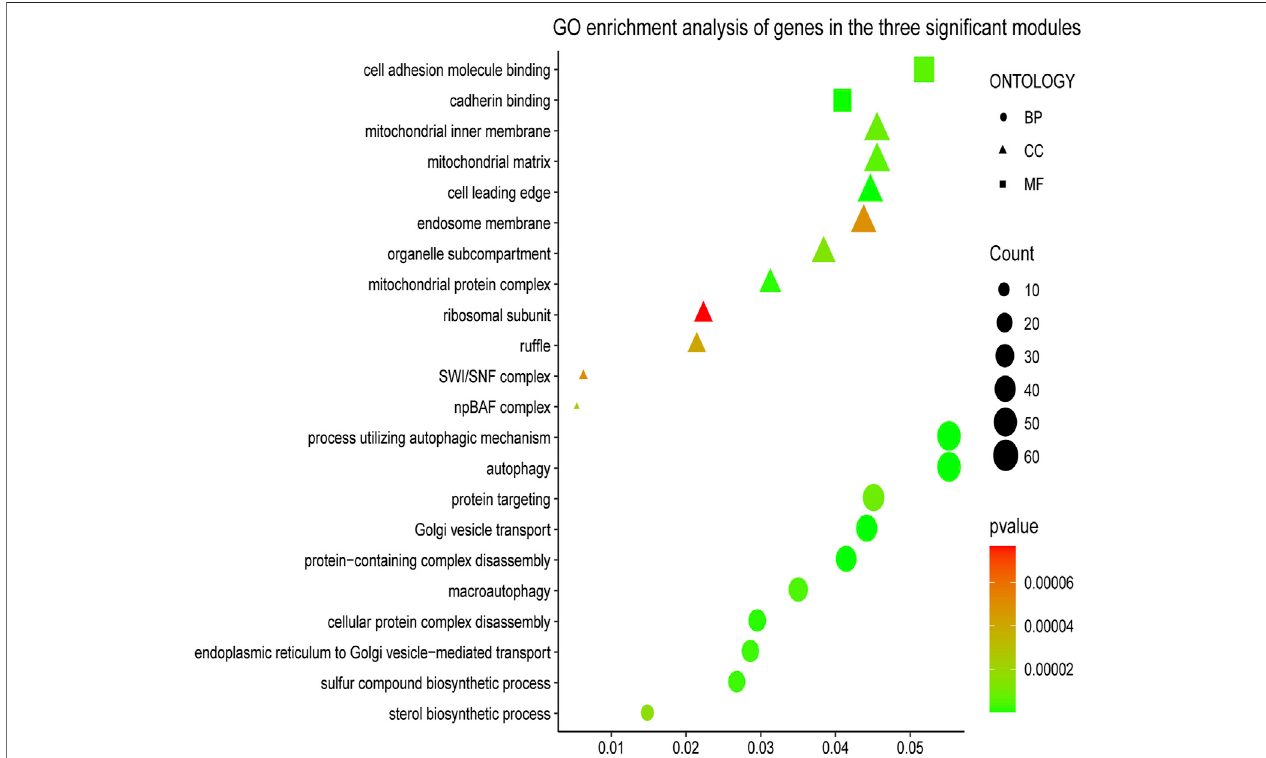
FIGURE 3 | Gene Ontology (GO) enrichment analyses of gene members in three chosen modules. The colored geometry represents GO term enrichment, dots represent biological process (BP), triangles represent molecular function (CC), rectangles represent cellular component (MF), red indicates low enrichment, and green indicates high enrichment. The sizes of the geometries represent the number of genes in each GO